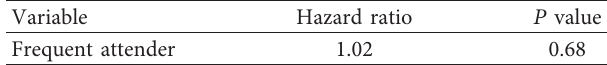
Table 3: Survival during study